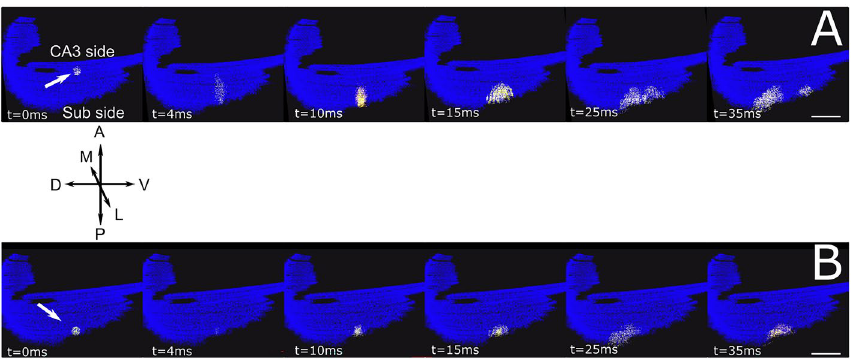
Figure 9. Full-scale network stimulation. Snapshots from a movie (suppl. Movie 2) illustrating a simulation in which the activity was evoked by a single pulse stimulation delivered to about 200 pyramidal cells in a 100 µm diameter sphere near the CA3 side. As in the case of Fig. 8, the activity propagates in the Antero-posterior direction from CA3 to subiculum to subsequently spread longitudinally while remaining confined to the subiculum side. Scale bar 1 mm. As in the case of Fig. 8, a neuron’s activity is color coded from blue (rest) to white (spike), to visualize action potentials, with a fixed 2 ms transition